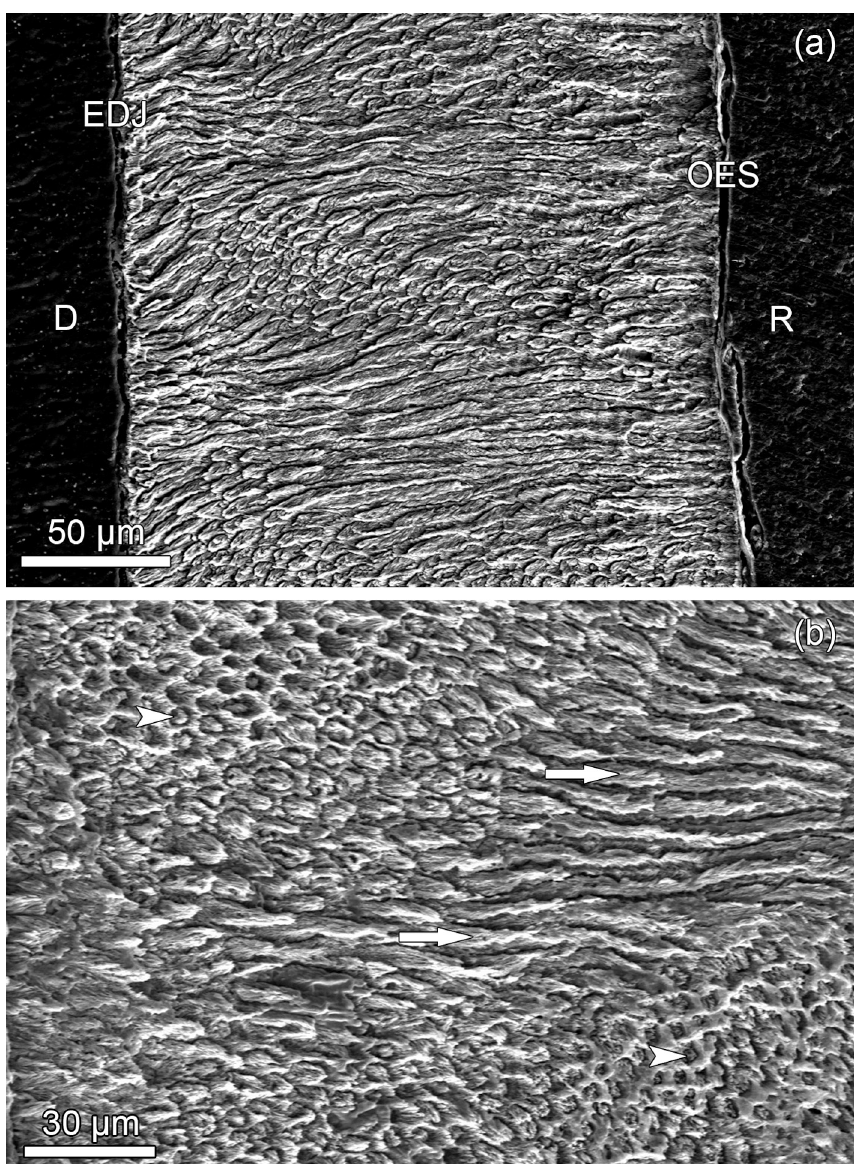
Fig 14. Enamel structure in longitudinally sectioned teeth of specimen ZMUC 69 3 ; SEM-SE images of etched polished cut surface. (a) buccal enamel of the right M 1 . The enamel is prismatic and shows Hunter-Schreger bands, i.e., alternating zones of more longitudinally and more transversely sectioned prisms. D: dentin; EDJ: enamel-dentin junction, OES: outer enamel surface; R: resin. (b) labial enamel of the right maxillary C showing zones with transversely (arrowheads) and longitudinally (arrows) sectioned prisms. The outer enamel surface is located to the left of the field of view.